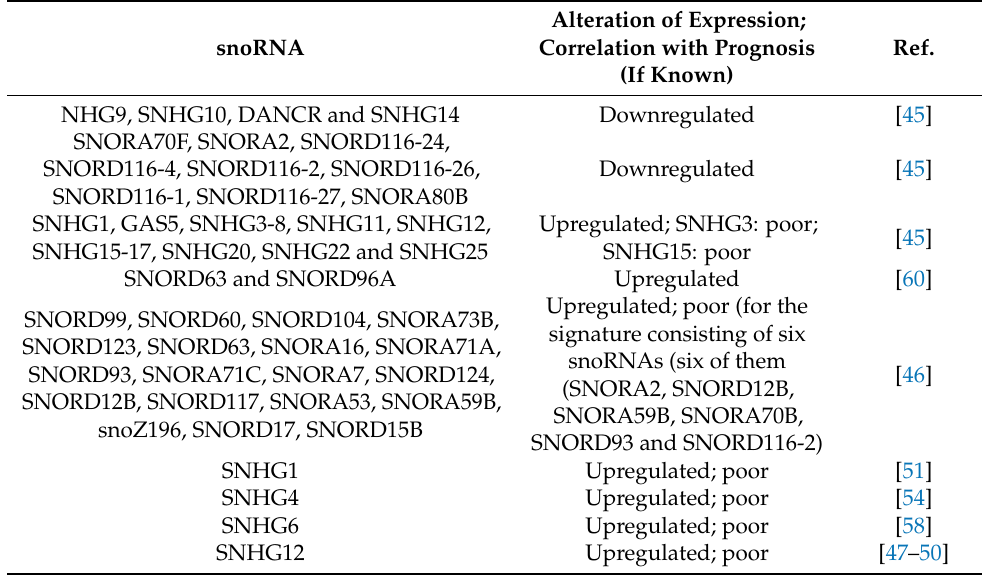
Table 1. snoRNAs with altered expression in ccRCC tumors when compared with